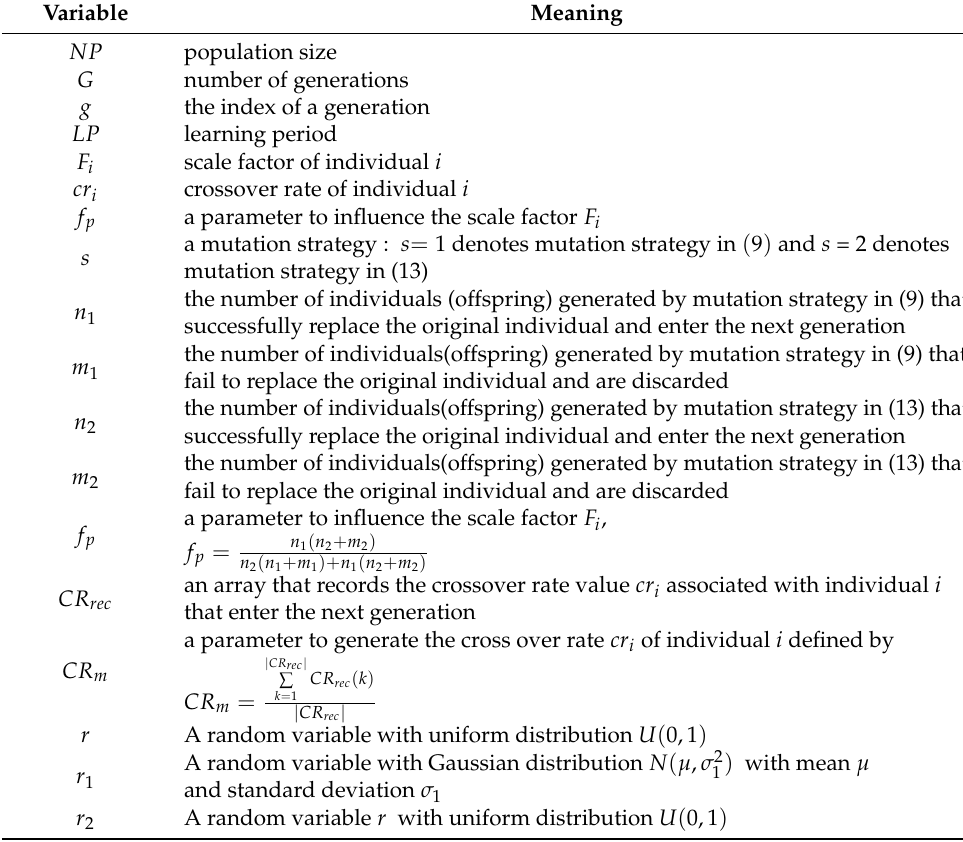
Table 2. Notations of symbols, variables and parameters used in the proposed